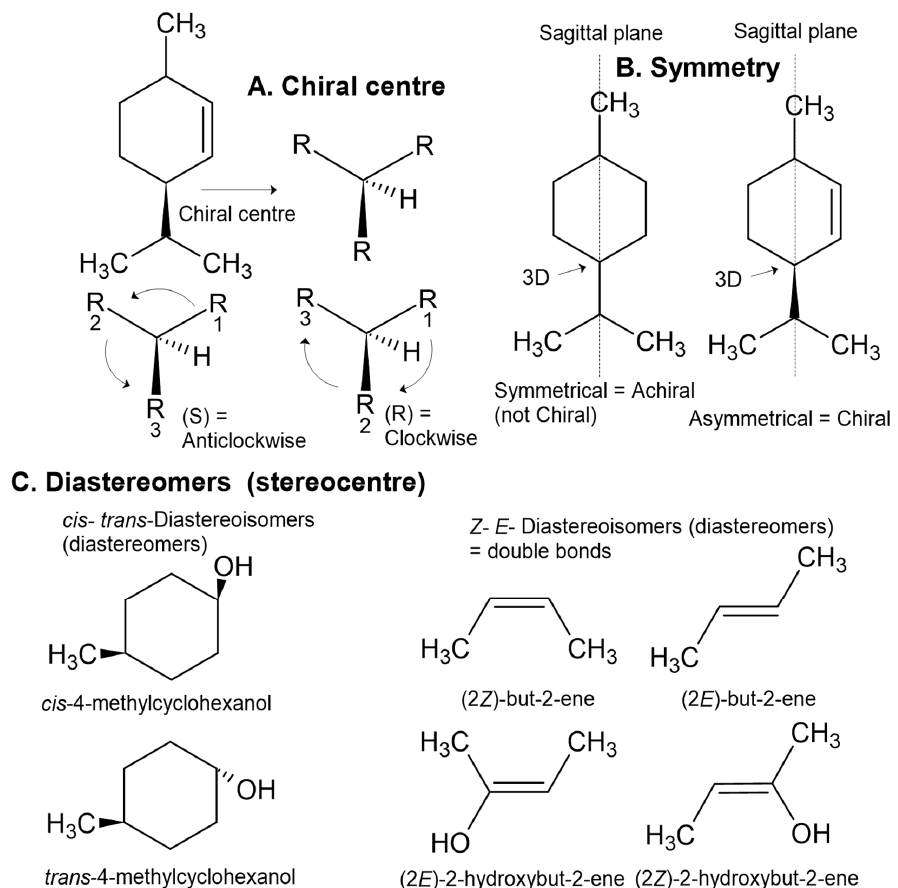
Figure 12. Chirality and cis/trans isomerism.